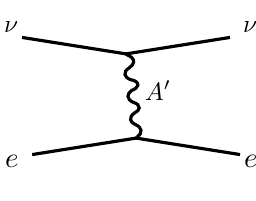
Figure 10 . Neutrino-electron scattering via A